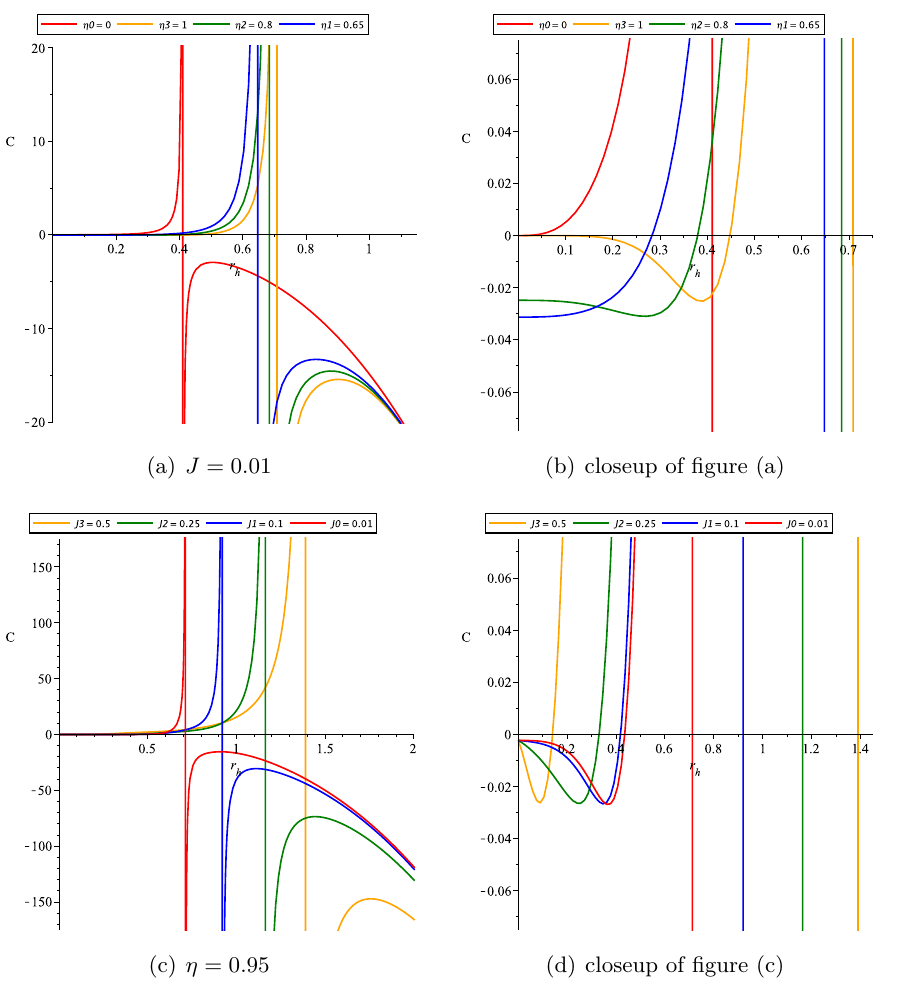
Figure 7 . Variations of the specific heat in terms of horizon radius r h , for the Myers-Perry black hole in five